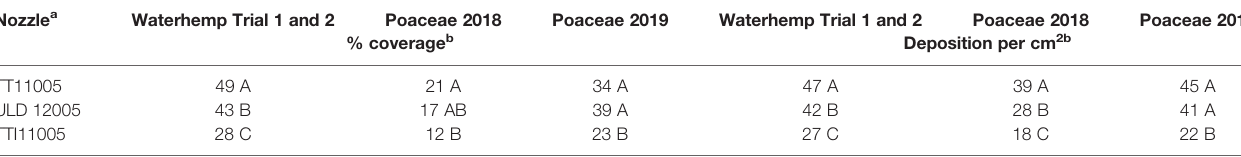
TABLE 4 | Percent coverage and depositions per cm 2 on spray cards as in fl uenced by nozzle